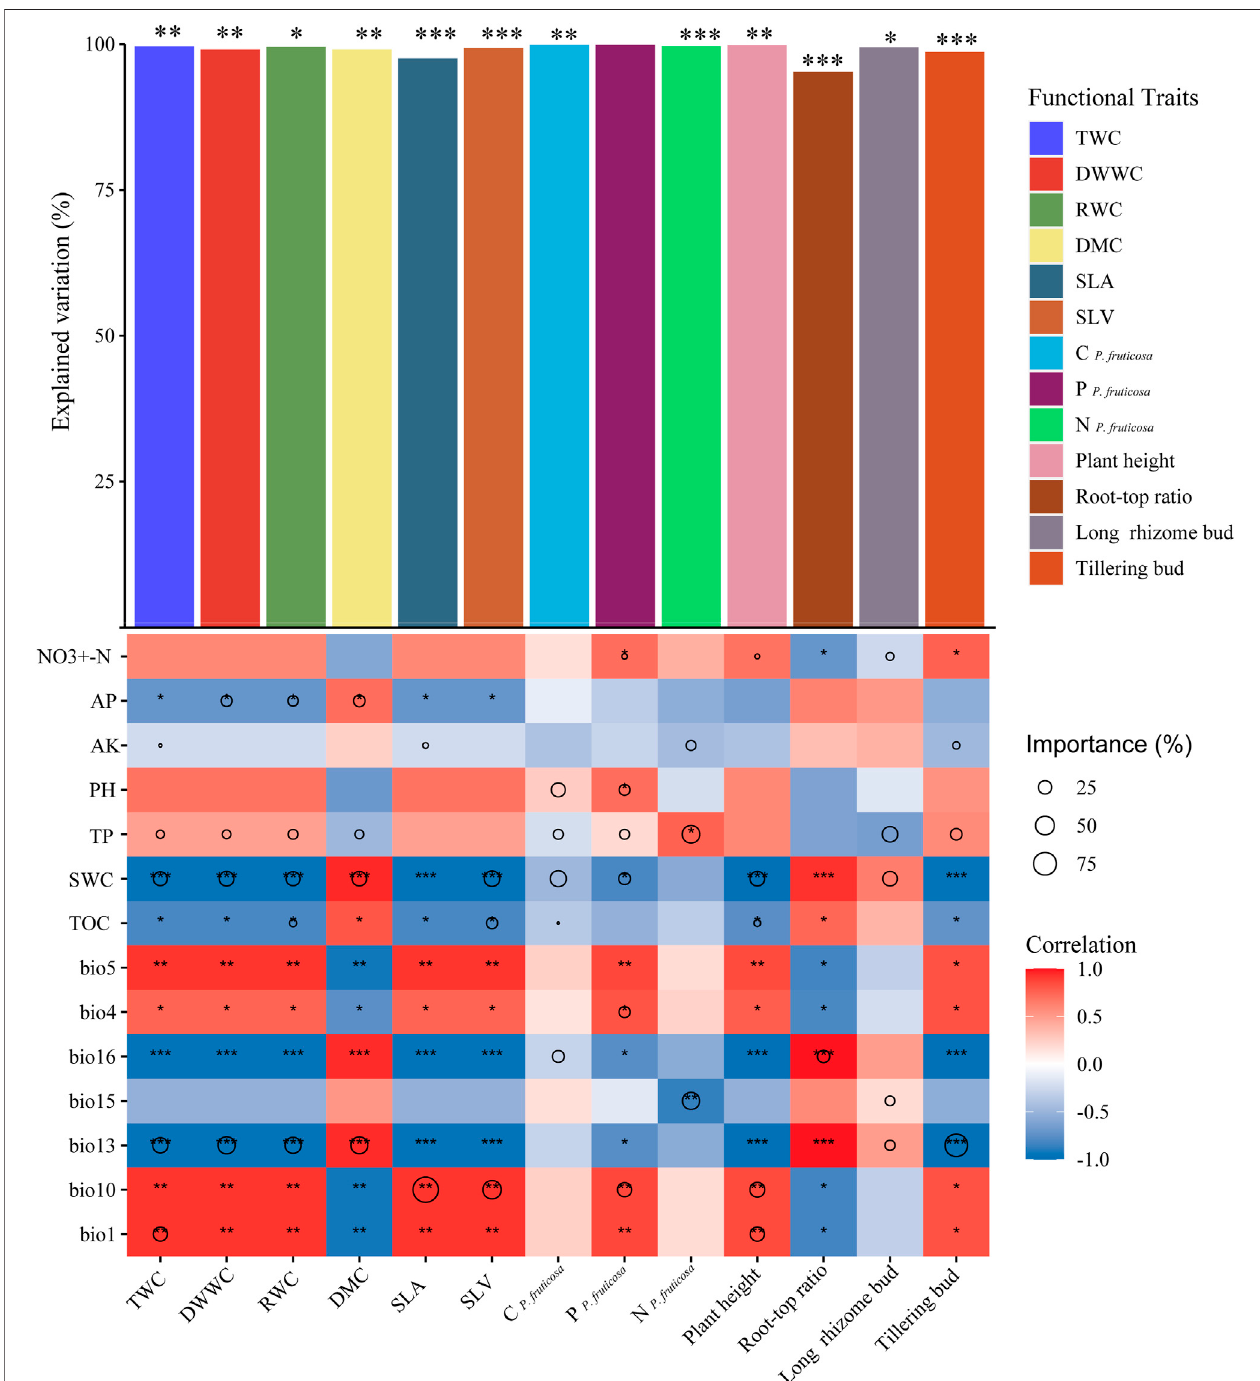
FIGURE 4 | Contribution of environmental variables to each functional trait of P. fruticosa . Spearman correlations between environmental variables and functional traits are shown by colors. The size of the circle re fl ected variation explained the rate of the selected variable. The signi fi cance of each functional trait explained by environmental variables is indicated by the asterisks above the bar (* p ＜ 0.05, ** p ＜ 0.01, *** p ＜ 0.001). NO 3 + -N, soil nitrate-nitrogen; AP, soil available phosphorus; AK, soil available potassium; pH, pH of the soil in 1:2.5 (mass:volume), TP, soil total phosphorus, SWC, soil water content, TOC, soil total organic carbon. bio1, annual mean temperature; bio4, temperature seasonality; bio5, the max temperature of the warmest month; bio10, mean temperature of the warmest quarter; bio13, precipitation of wettest month; bio15, precipitation seasonality; bio16, precipitation of wettest quarter. TWC, total water content; DWWC, dry weight water content; RWC, relative water content; DMC, dry matter content; SLA, the speci fi c leaf area; SLV, speci fi c lobe volume; C P. fruticosa. , leaf carbon concentration; P 。 fruticosa , leaf phosphorus concentration; N P. fruticosa , leaf nitrogen concentration; Plant height, plant height of P. fruticosa ; Root – top ratio, the ratio of root to aboveground biomass; Long rhizome bud, long rhizome bud number of P. fruticosa ; Tillering bud, tillering bud number of P. fruticosa .